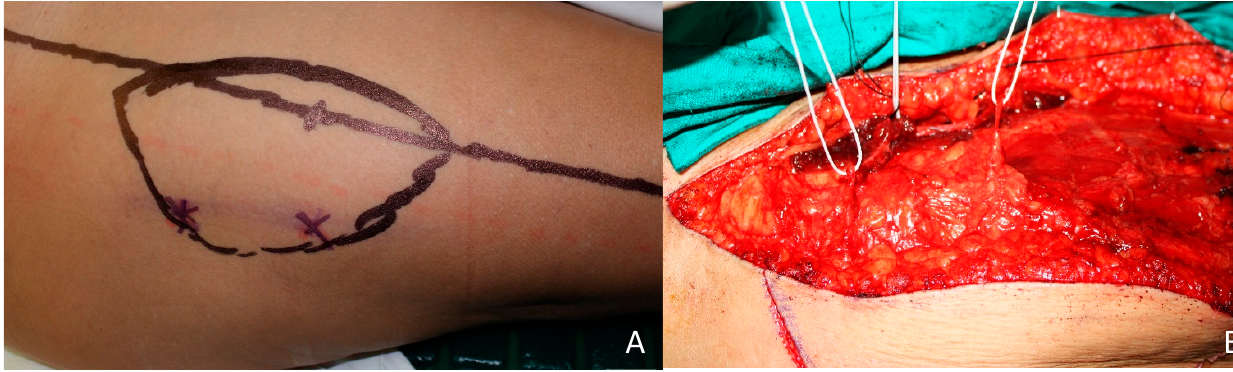
Figure 8. ALT flap. ( A ) Preoperative design of the ALT flap based in two perforators. ( B ) Musculocutaneous perforators identified during ALT flap dissection.